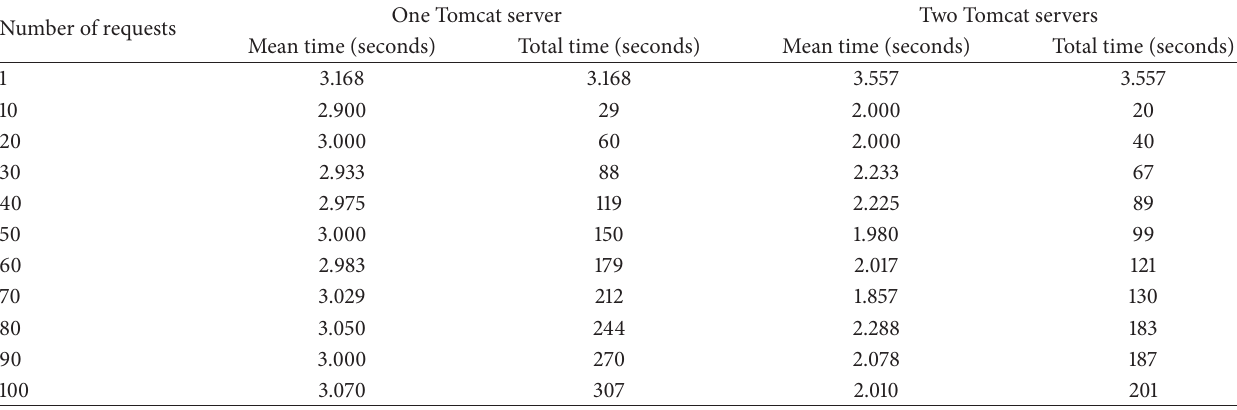
Table 4: Times required to submit different numbers of requests within 10 seconds when using an RSA